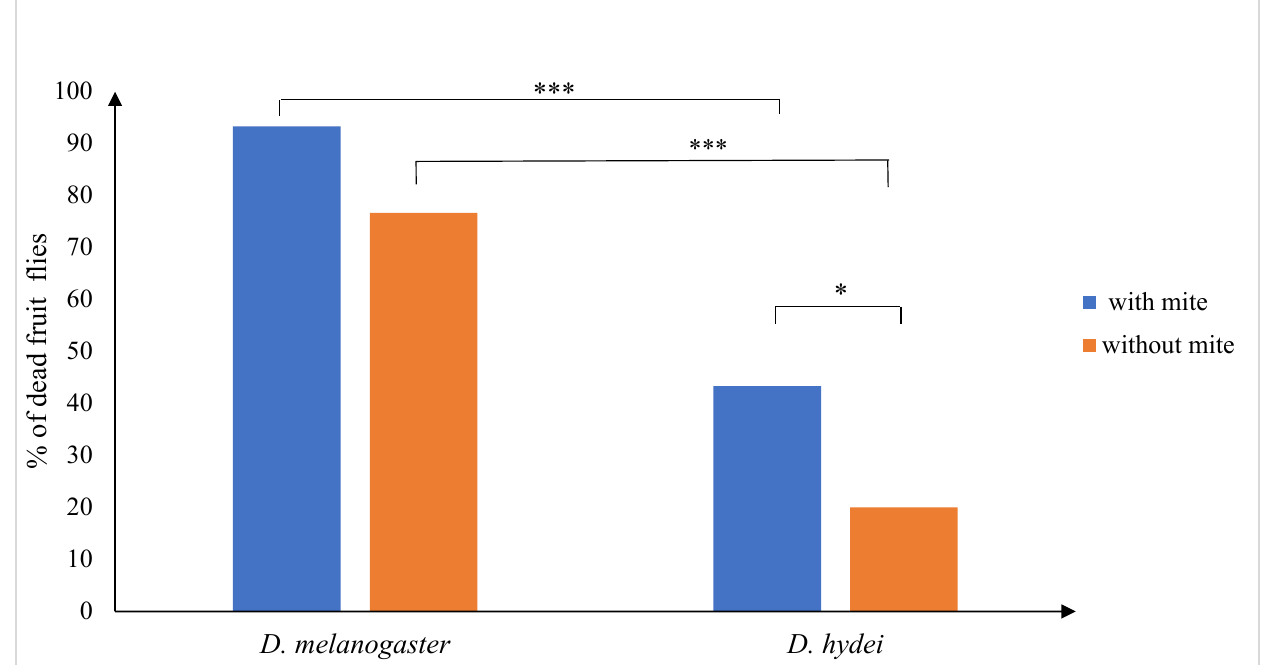
Figure 5. Mortality of Drosophila melanogaster and D. hydei female fruit flies during a 24 h stay with and without Blattisocius mali females in the observation chambers. Number of tested flies in each combination was n = 30. * 0.01 < p ≤ 0.05, *** p < 0.001. On the contrary, in D. hydei , after 24 h, in combination with a mite, a significantly higher percentage of dead flies of this species was recorded than in the control. ( χ 2 = 4.9, df = 1, p = 0.0443) (Figure 5).